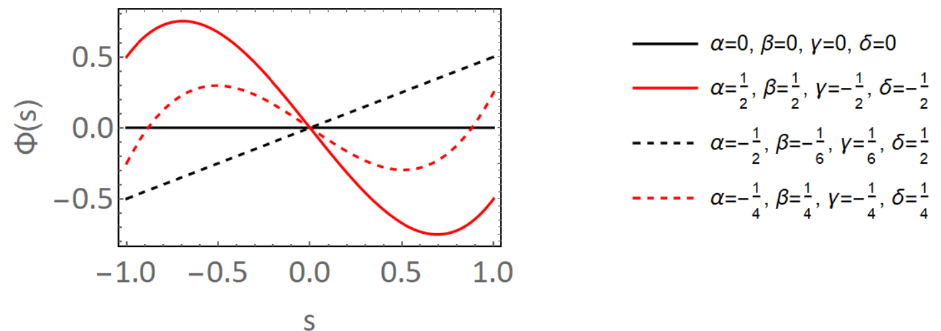
Figure 4. Wavy CNT shapes generated by selection of coefficients of waviness generation func- tion Φ ( s )